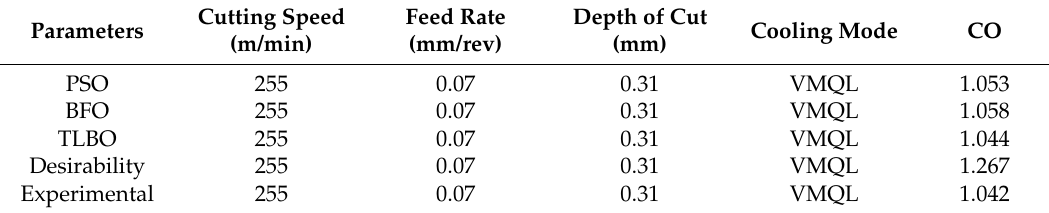
Table 8. Optimal parameter